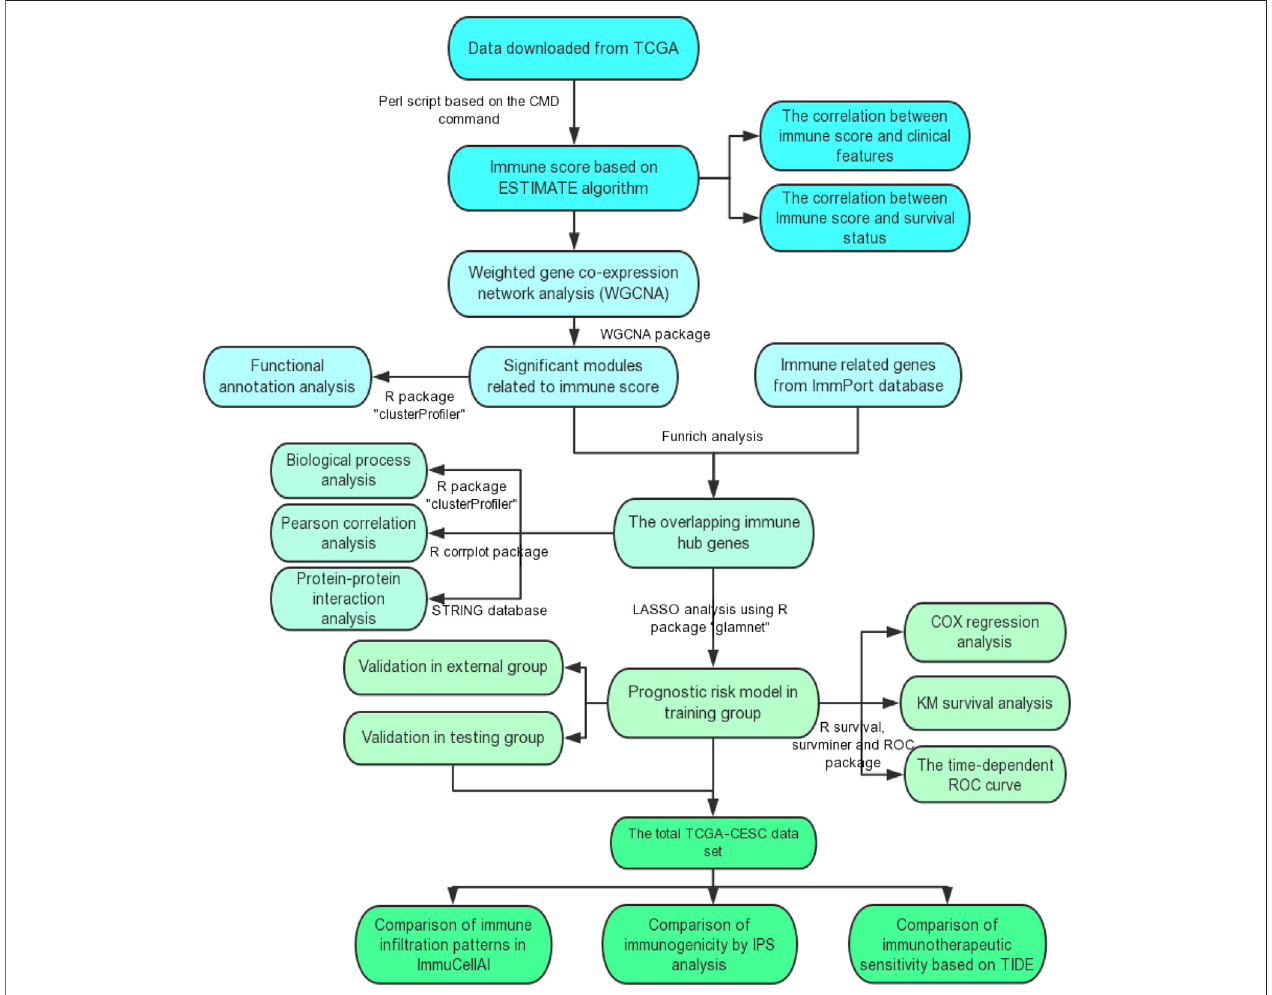
FIGURE 1 | The fl ow diagram of this study. TCGA, the Cancer Genome Atlas; GO, Gene Ontology; KEGG, Kyoto Encyclopedia of Genes and Genomes; ROC curve, receiver operating characteristic curve; IPS, Immunophenoscore; TIDE, the Tumor Immune Dysfunction and Exclusion.